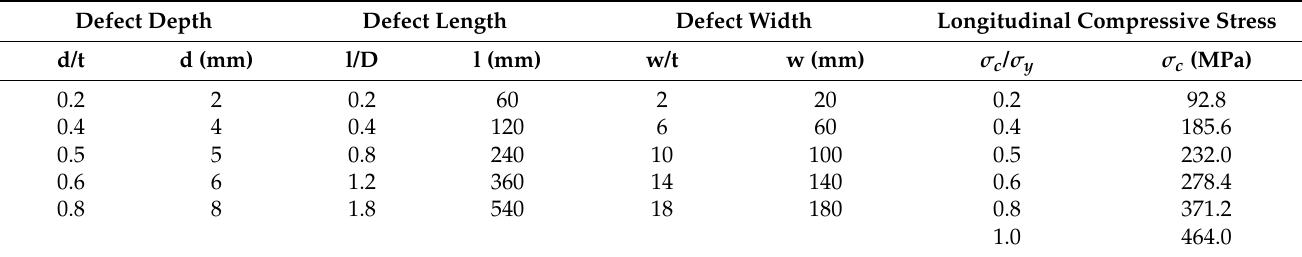
Table 2. Parameters of corrosion defect geometries and external load.